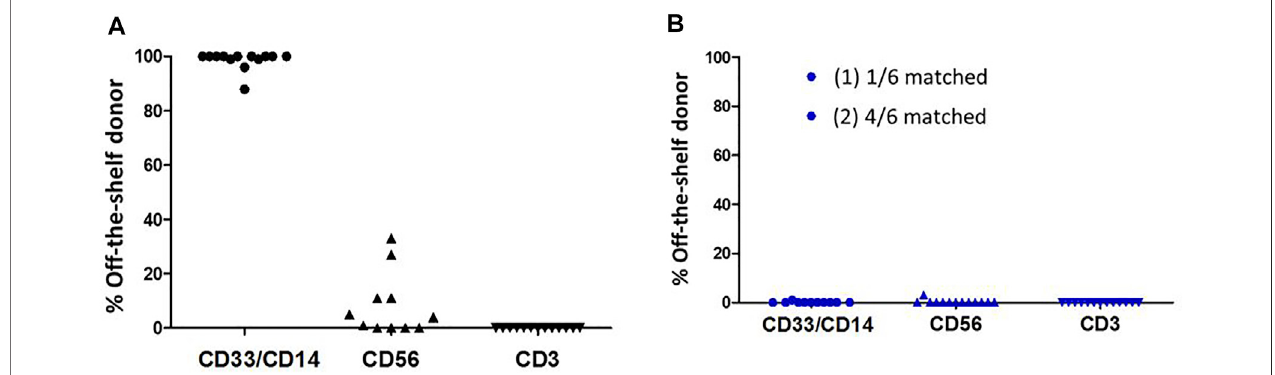
FIGURE 3 | Persistence in peripheral blood of cells derived from the expanded cell graft at day 7 ( Figure 3A ) and at day 14 ( Figure 3B ).